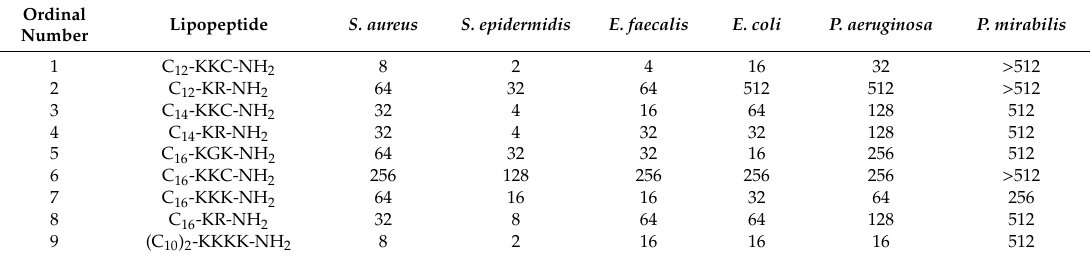
Table 3. Minimum inhibitory concentration (MIC) of the lipopeptides ( µ g /